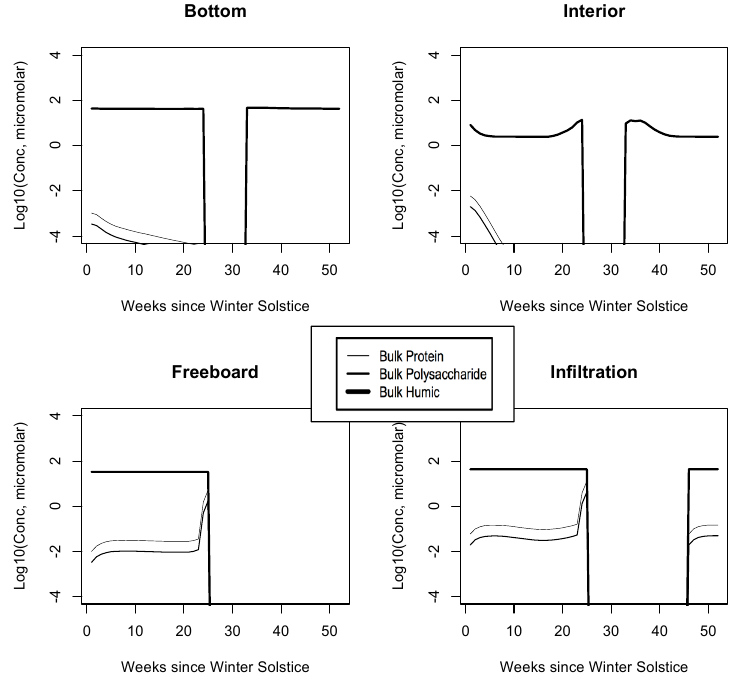
Figure 12. Central Arctic, caption as in Figure 9.